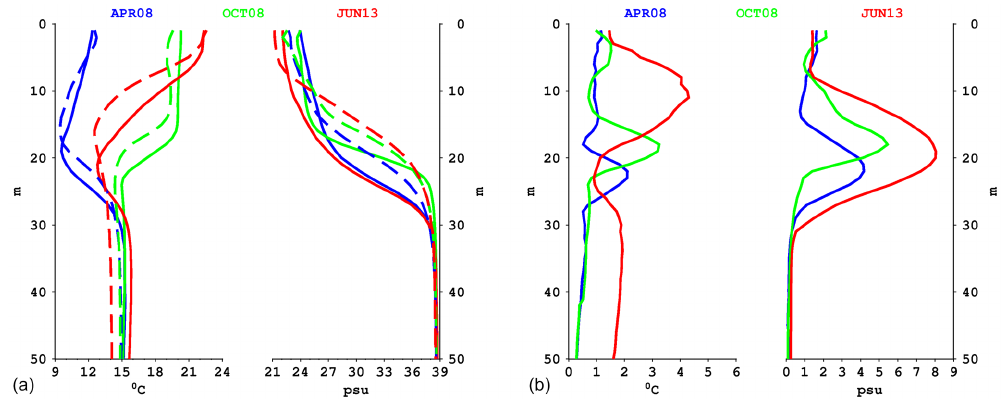
Figure 9. (a) Mean temperature and salinity profiles of observations (dashed) and simulation (line) and (b) vertical distributions of RMS errors in April 2008 (blue), October 2008 (green) and June 2013 (red).